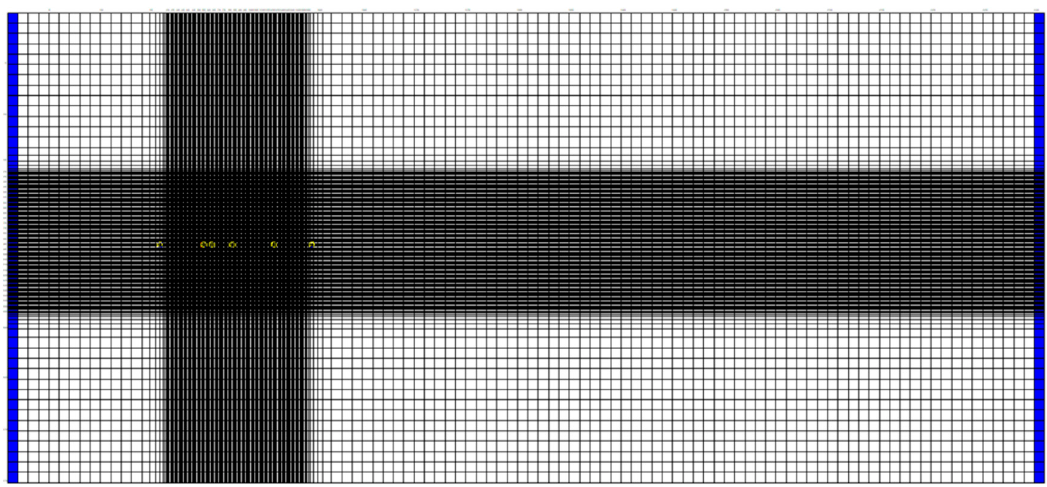
Figure 6. Horizontal grid discretization for numerical models A, B, C, and D.